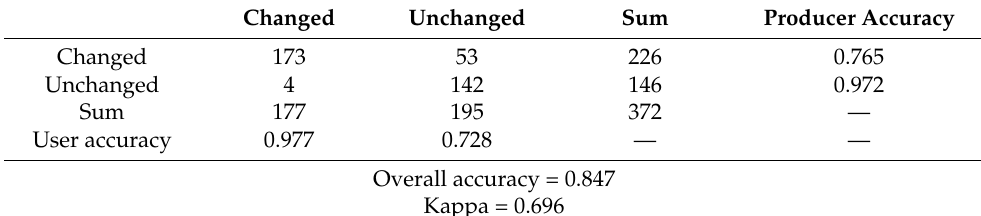
Figure 15. Object-based change test results for ( a ) GF-1 and ( b ) Landsat imagery. Table 4. Change detection accuracy of object-based GF-1 imagery.